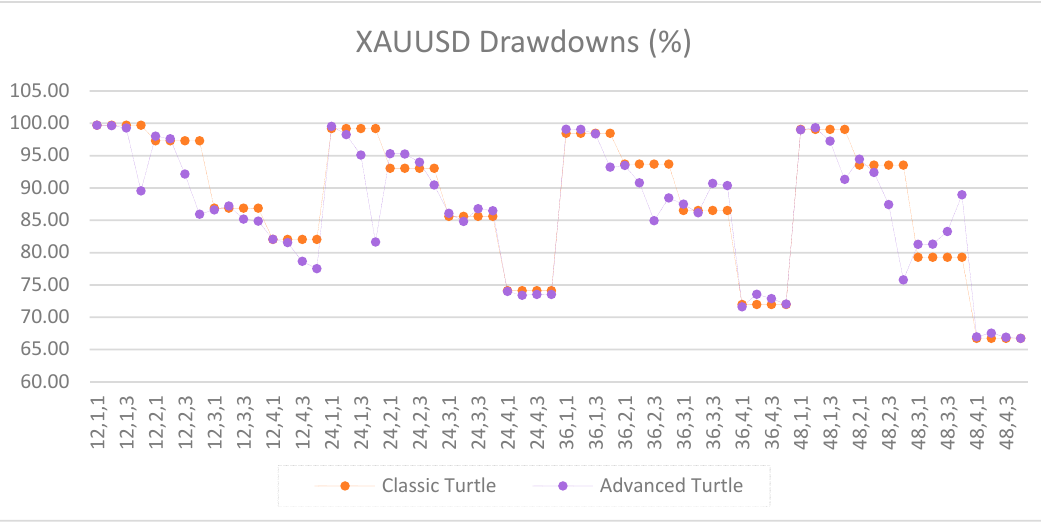
Figure A12. Drawdowns of XAUUSD as percentage of equity between the classic and the advanced Turtle systems for every combination of N, X, Y for the fast parameters (20, 40).